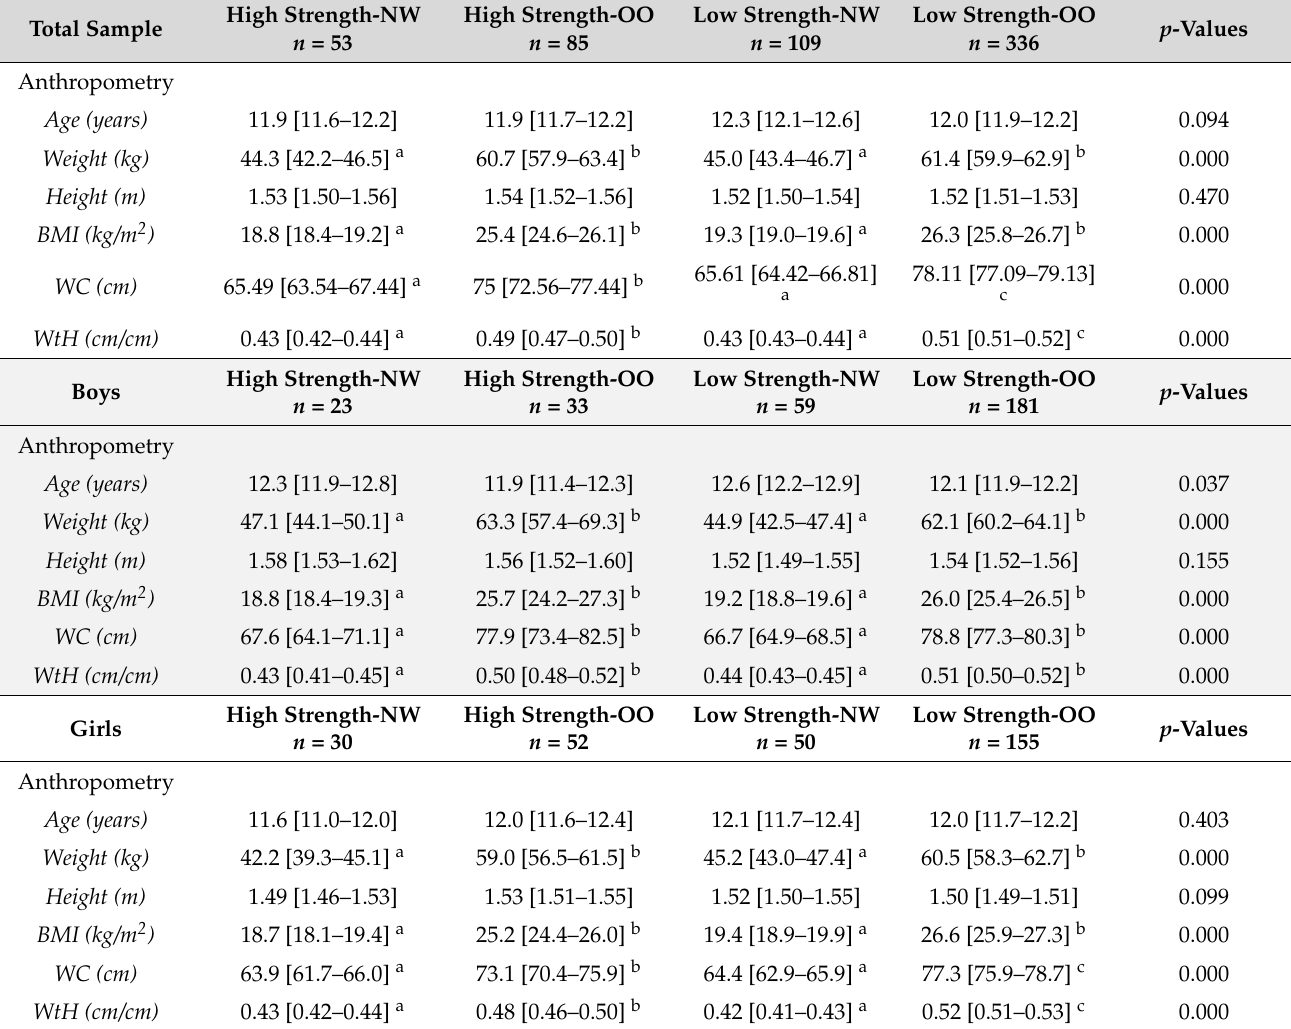
Table 2. Anthropometric characteristics of the total sample according to group and